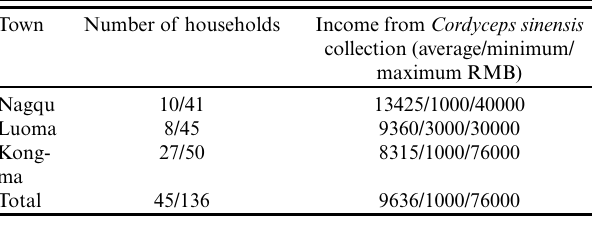
Table 7 . The impact of caterpillar fungus collection on local herders’